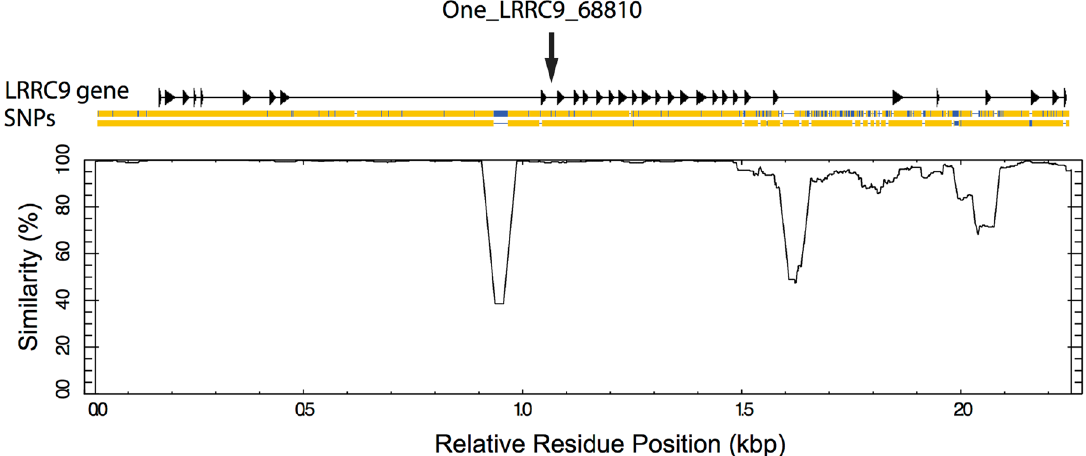
Figure 3. Sequence similarity between the shore- and stream-spawning sequences for the LRRC9 genomic region of Oncorhynchus nerka from Okanagan Lake kokanee. Exons for the LRRC9 gene shown at top as arrows, introns are shown as the intervening line, along with the One_LRRC9_68810 SNP location. SNPs are shown as blue vertical lines and indels shown as gaps in the sequence, with identical sequence in orange. “Shore-allele” sequence: top, “stream-allele” sequence: bottom. Similarity is defined as the percentage of identical sites within a 500 bp window centred on this